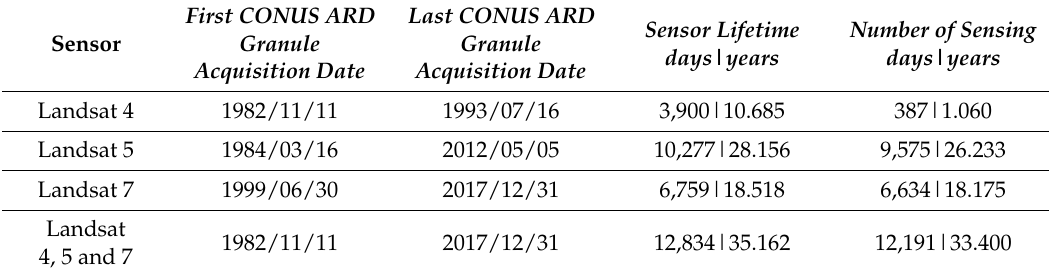
Table 1. CONUS ARD sensor summary information over the 36 year study period (1 January 1982 to 31 December 2017). The sensor lifetime and number of sensing days are shown with units of days and